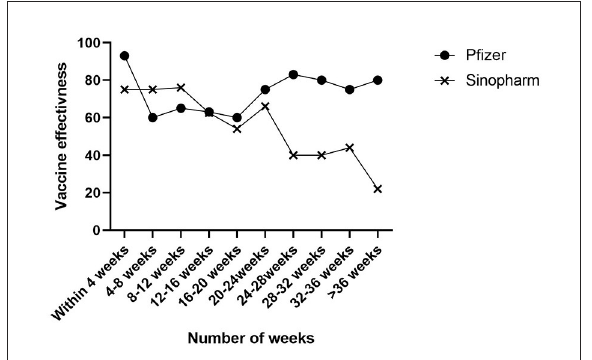
FIGURE2 Change in vaccine effectiveness based on number of week after 2 dose Pfizer and Sinpoharm COVID-19